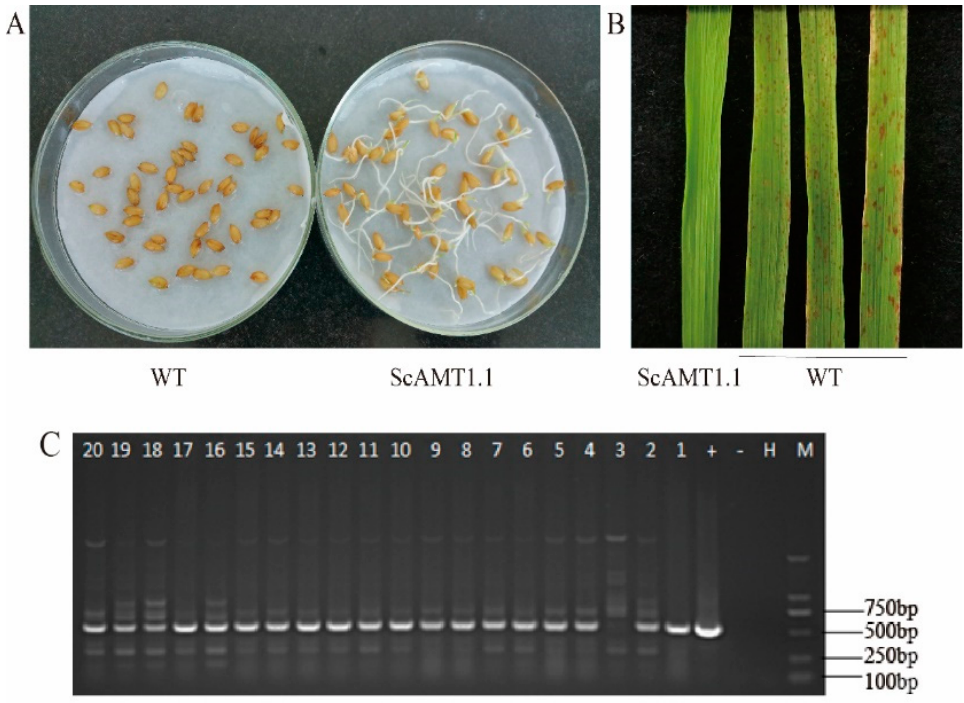
Figure 5. Identification of transgenic-positive rice plants. Notes: ( A ), The seeds germinate during soaking with 0.1% Basta solution. ( B ), The typical phenotype of the leaves spraying with 0.2% Basta solution. ( C ), Analysis of PCR amplification products by gel electrophoresis. WT: wild-type; ScAMT1.1: ScAMT1.1 -overexpressing transgenic rice. M: 2000 bp DNA marker; H: H 2 O (blank control); -: negative control (wild-type rice); +: positive control (pBWA(V)BU-ScAMT1.1 plasmid), 1–20: different transgenic rice lines. The PCR product for the target sequence is 512 base pairs. 2.4. Phenotypic Index Analysis Shows Overexpressing ScAMT1.1 Enhances Plants’ Height and Fresh Weight in the Transgenic Rice under Low N Stress Four homozygous T3 generation transgenic lines (T-2, T-5, T-6, and T-12) were obtained according to the methods described in 4.4. Compared to the other transgenic lines, higher ScAMT1.1 expression levels in the transgenic lines of T-5, T-6, and T-12 were found by qRT-PCR (Figure 6A), and thus they were used to investigate the agronomic traits in the following assay. The transgenic lines showed a better performance than the wild-type plants under low N stress. After culturing for 16 d under low N nutrient solution, transgenic rice seedlings of T-5, T-6, and T-12 grew significantly better than the wild-type (Figure 6B), and their plant height was 46.83%, 26.58%, and 36.03% higher than that of the wild-type (Figure 6C), respectively. In addition, their fresh weight was 59.30%, 43.02%, and 52.33% higher than that of the wild-type, respectively (Figure